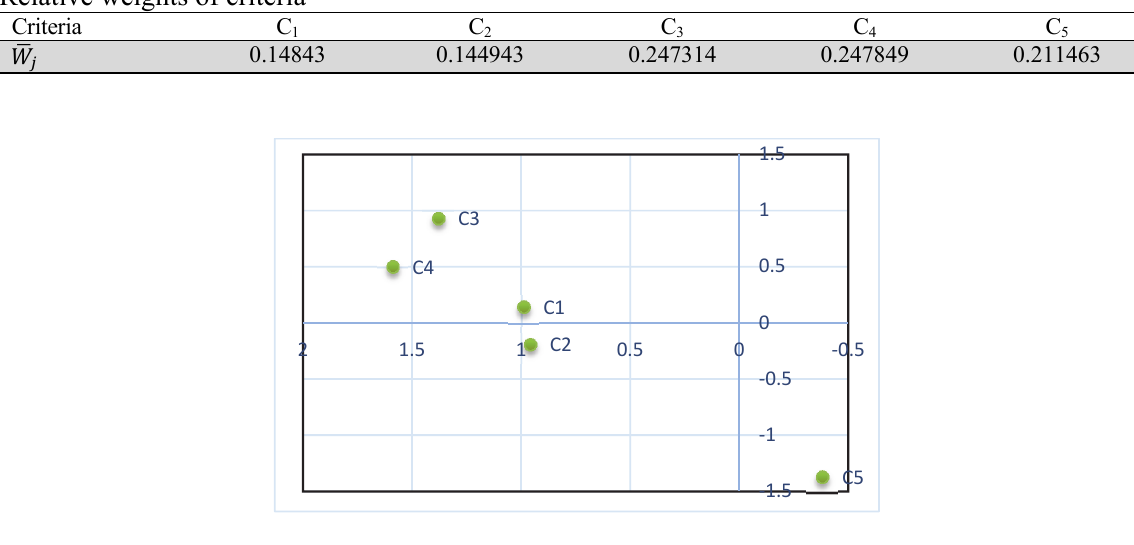
Fig. 2. Influential relation map among the